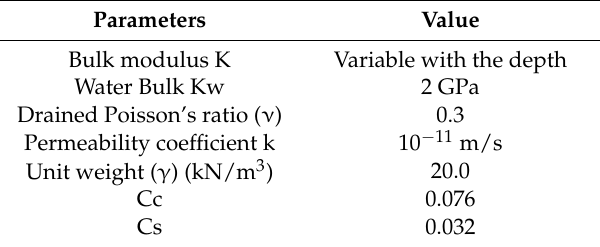
Table 7. Model parameters.